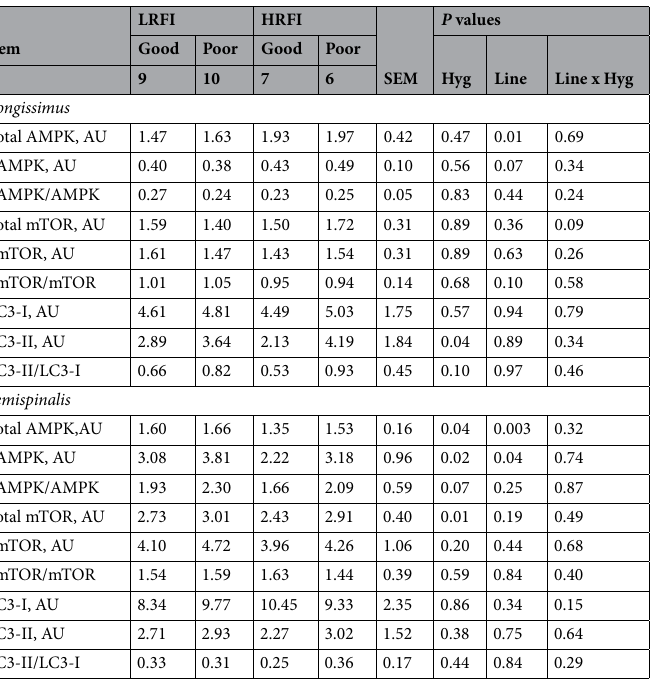
Table 4. Protein abundances of AMP-activated protein kinase α (AMPK), mammalian target of rapamycin (mTOR) and microtubule-associated protein 1 light chain 3β (LC3-I and II isoforms) in longissimus and semispinalis muscles of low (LRFI) and high (HRFI) residual feed intake (RFI) pigs raised in good or poor hygiene conditions. Proteins were quantified by western blot and expressed as arbitrary units (AU). pAMPK refered to Thr172 phosphorylated AMPKα and pmTOR to Ser2448 phosphorylated mTOR. Values are LS